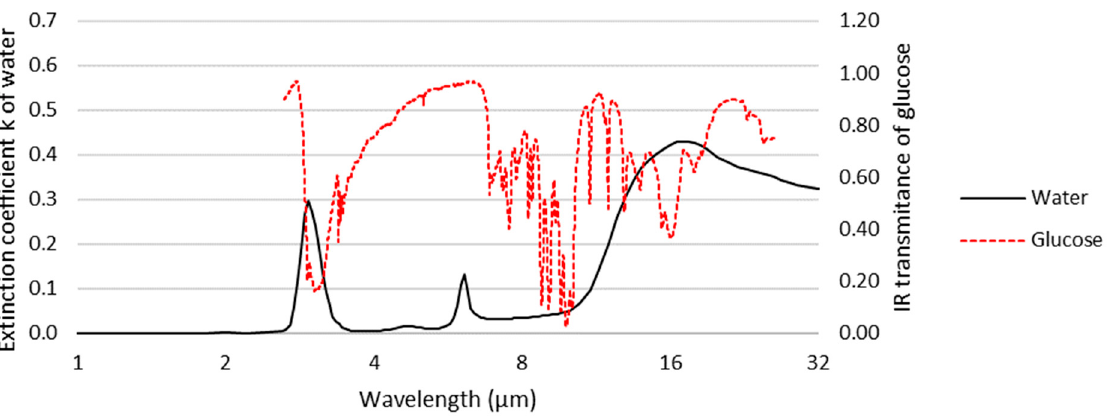
Figure 1. Extinction coefficient of water superimposed on the infrared spectrum of glucose (using data adapted from [12,13]). Water strongly absorbs at wavelengths corresponding to several of the characteristic bands of glucose, hindering its observation in aqueous samples by infrared spectroscopy.